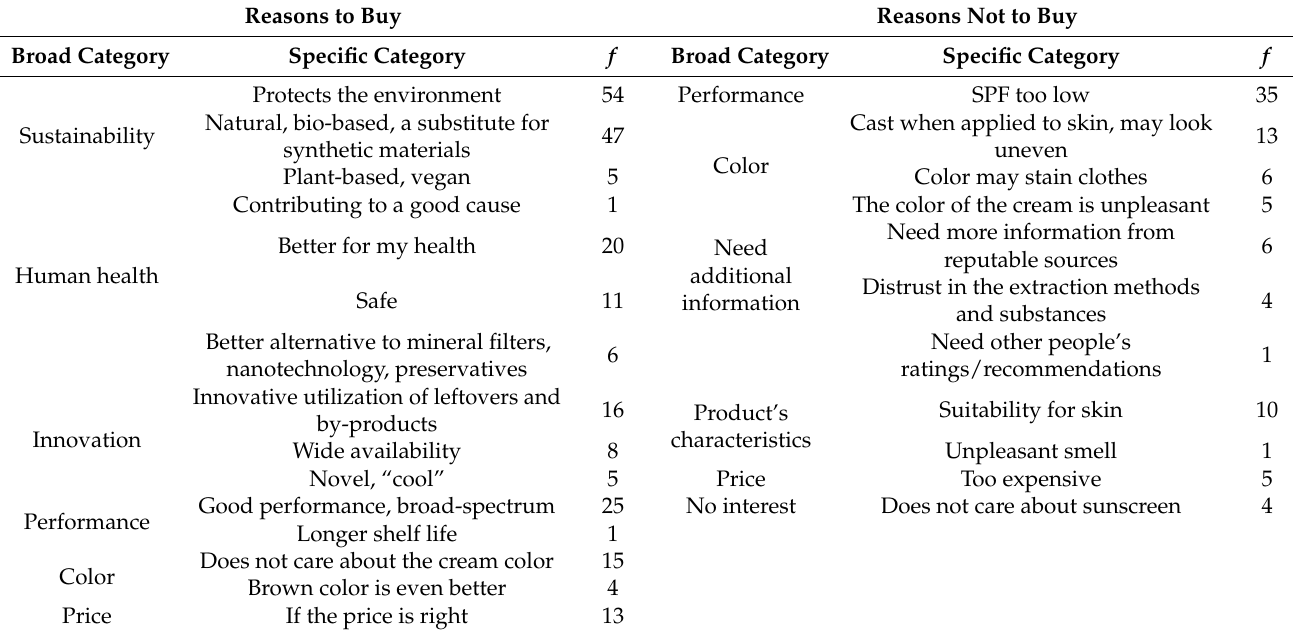
Table 2. Categories of responses to “Can you briefly describe your thoughts and reasons for (not) wanting to buy this